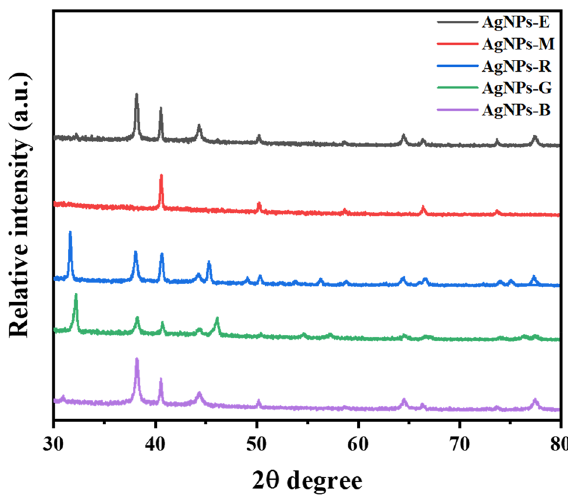
Figure 4. XRD pattern of AgNPs biosynthesized using the leaf extracts of Eucalyptus , Melia , Ruta , Geranium , and Basil